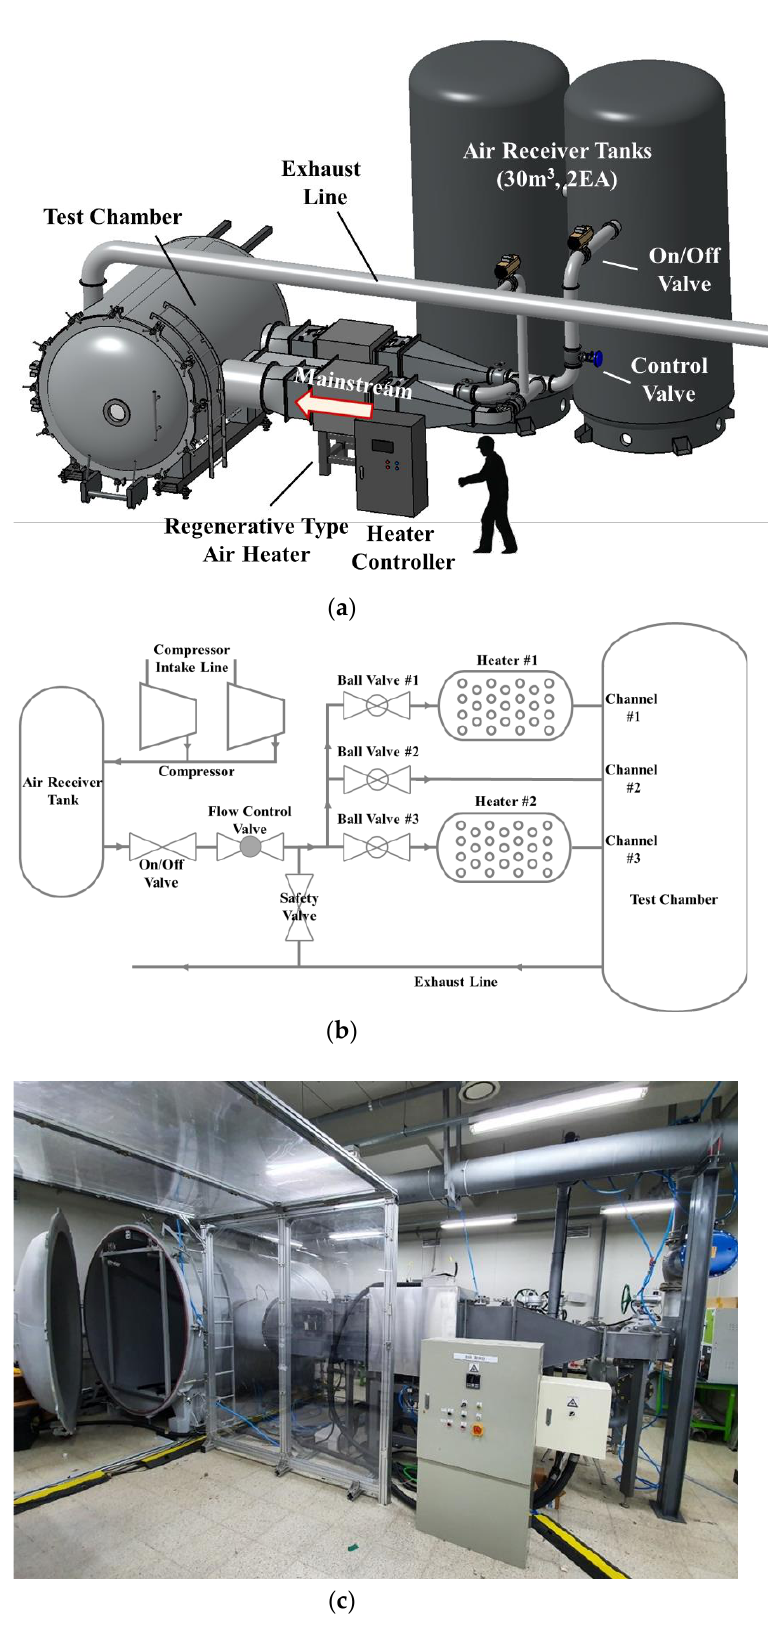
Figure 1. Schematic of test facility ( a ) Layout of test facility; ( b ) Schematic diagram of test facility; ( c ) Actual picture of test rig .